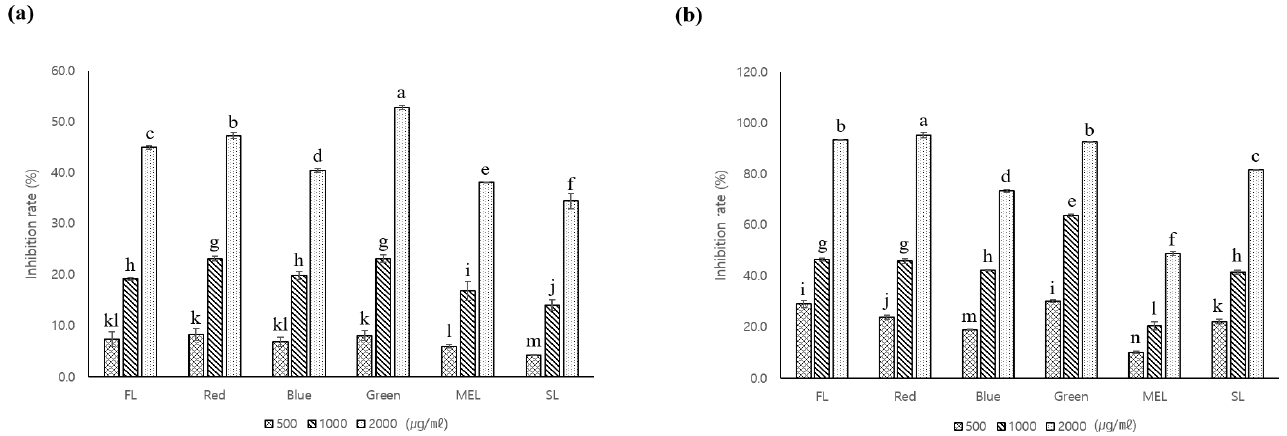
Figure 2. The inhibition rate of DPPH free radical scavenging activities of aerial ( a ) and underground ( b ) parts from extracts of A. macrocephala under different light sources. Values represent mean of data obtained from three independent experiments ( p < 0.05). Significance was indicated with different letters according to statistical analysis.